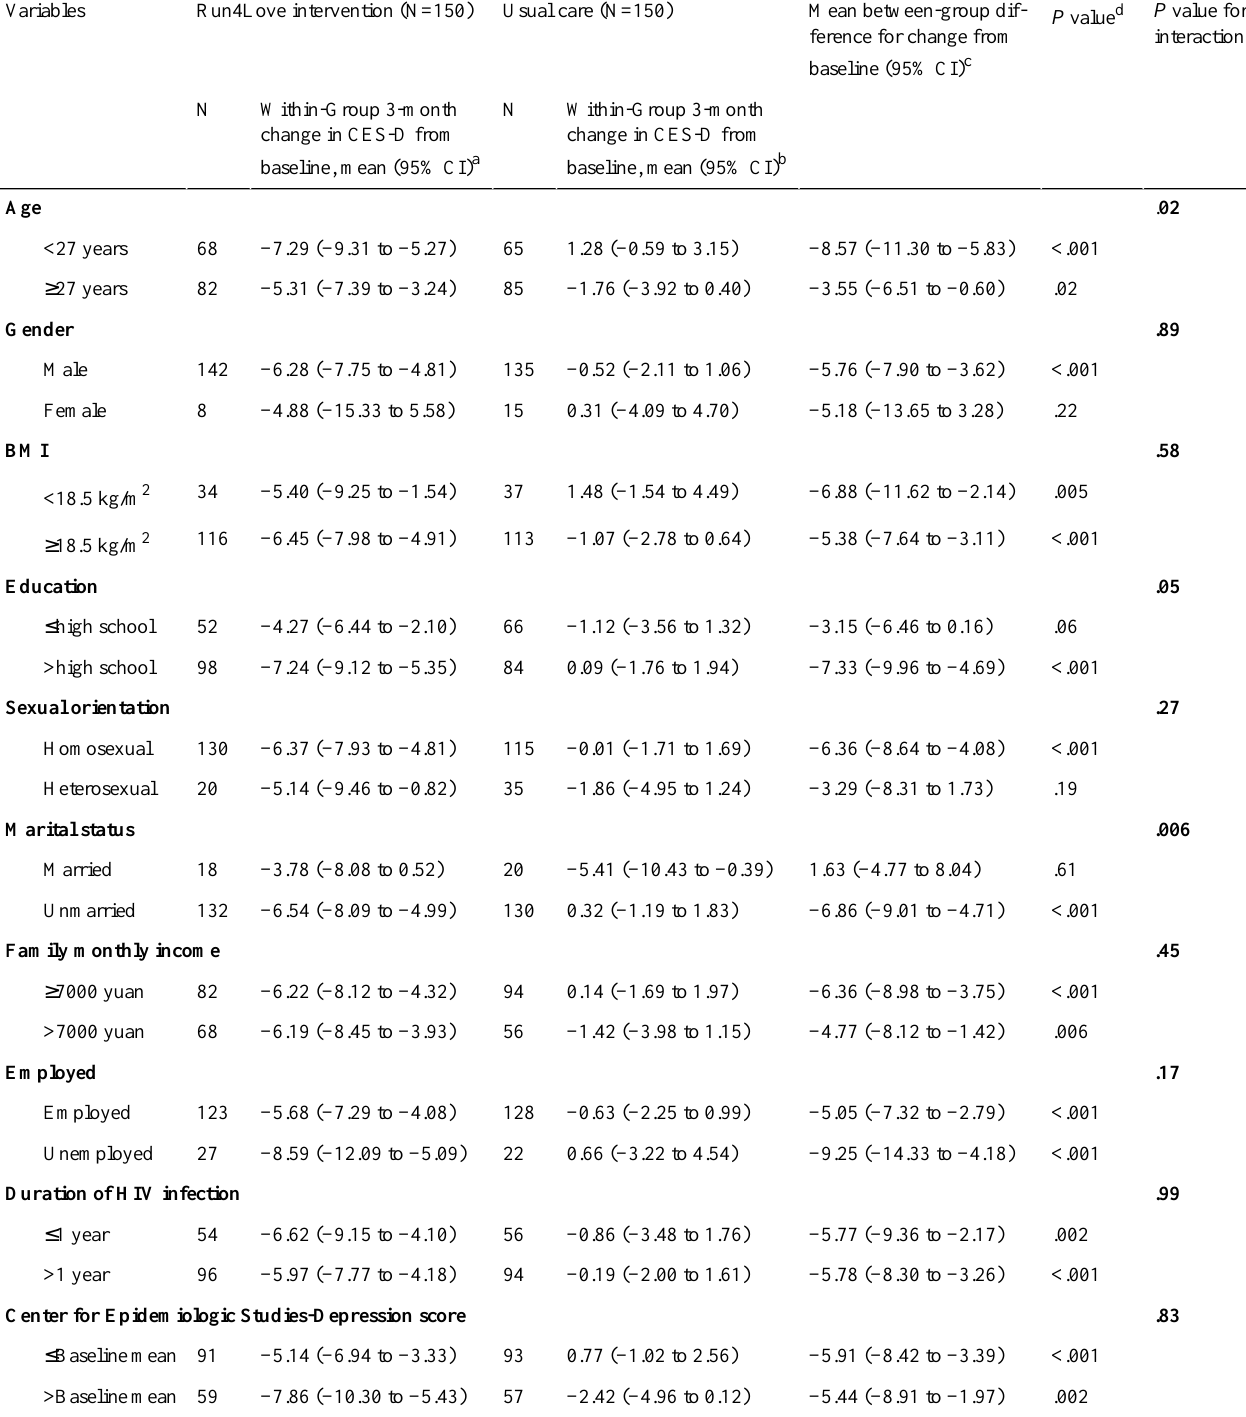
Table 5. Change in depression in study groups by participant characteristics.